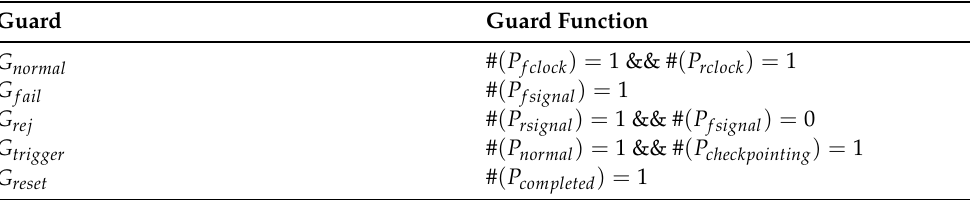
Table 1. Guard functions.